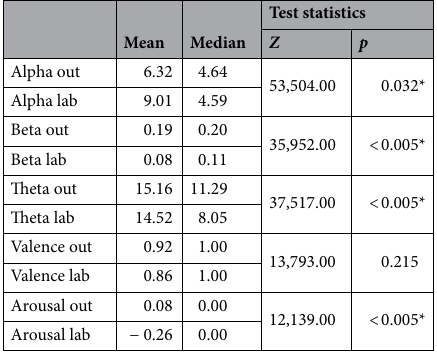
Table 3. Results of Wilcoxon Signed-Ranks Tests performed to explore differences between laboratory and outdoor setting. *Denotes statistically significant difference.